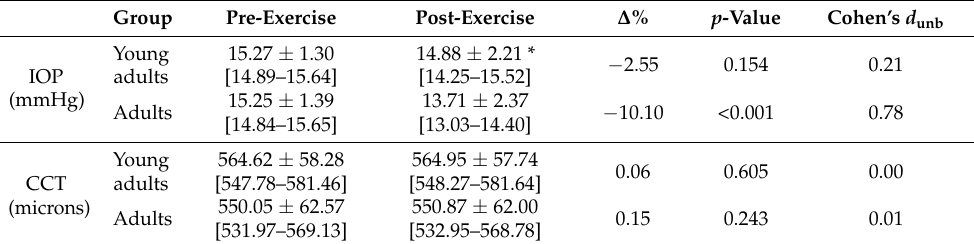
Table 4. Data comparison between the pre- and post-exercise intraocular pressure values, according to the age of the participants (young adults [minor or equal to 25 years], n = 21; adults [older than 25 years], n = 28).